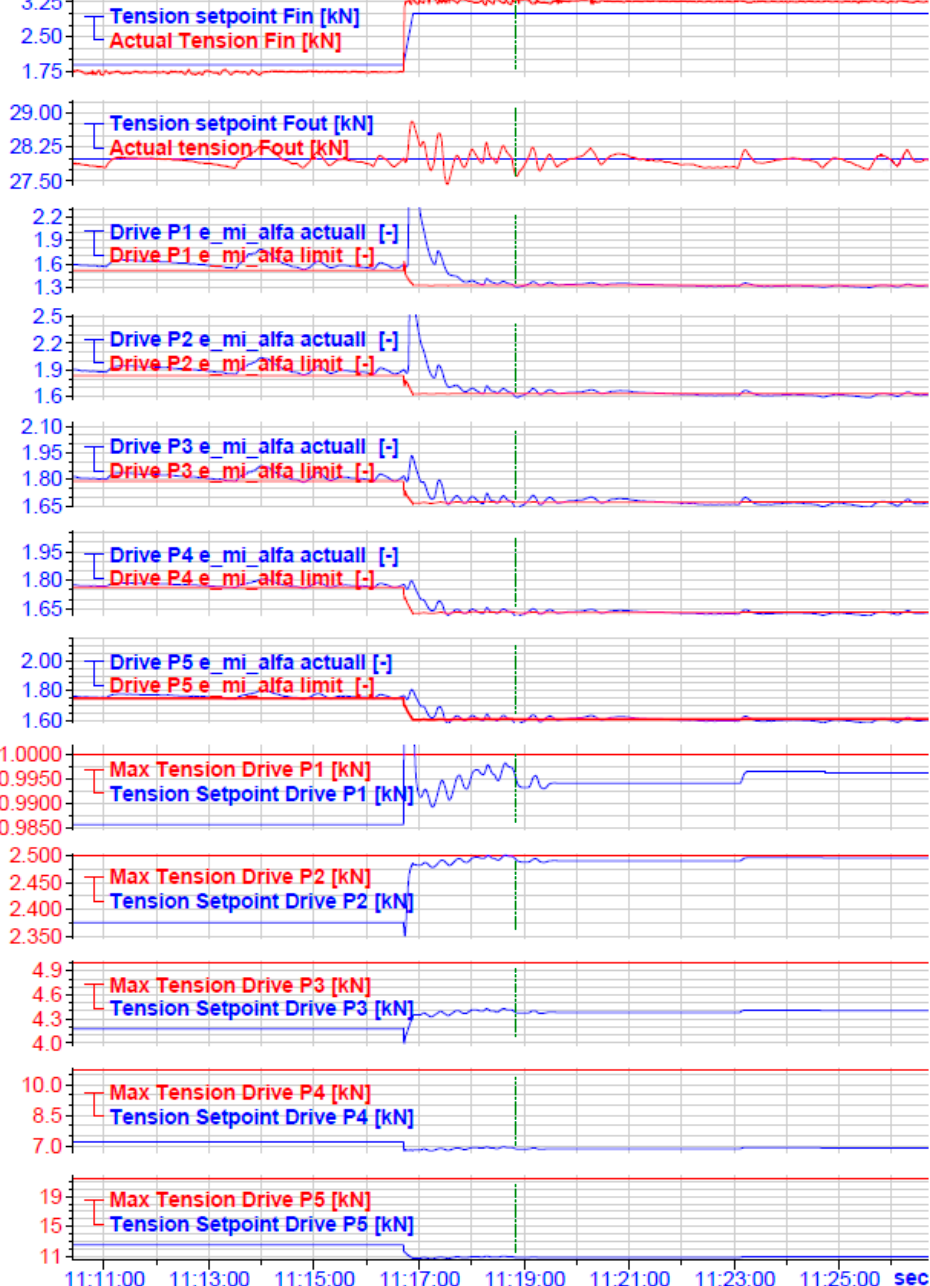
Figure 8. Experimental results of dynamic tension distribution in a realistic production line.